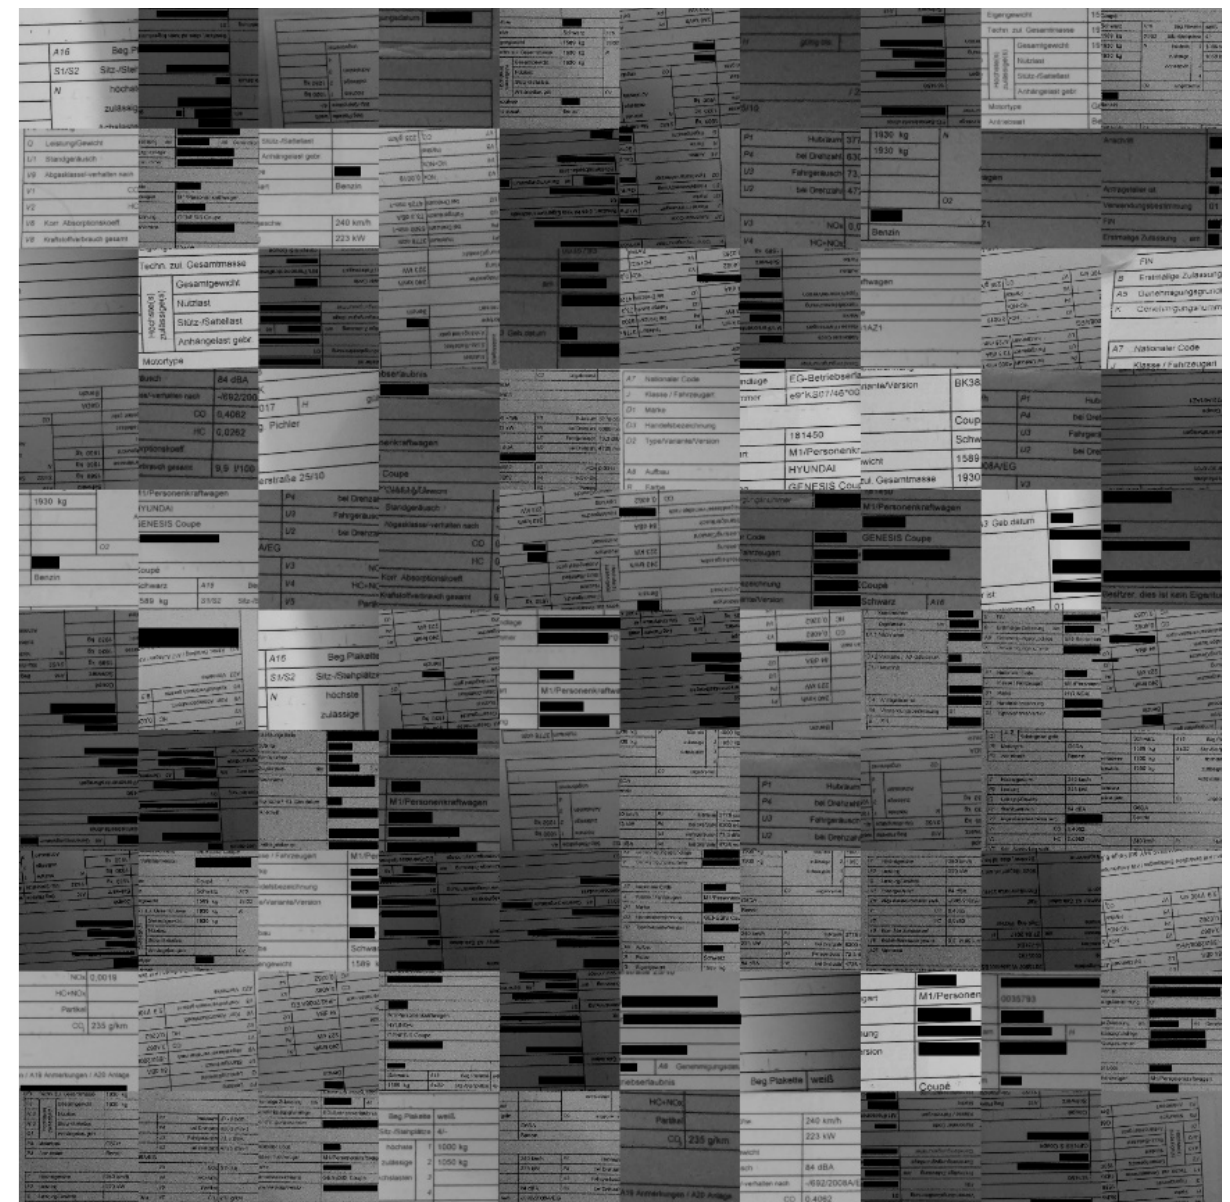
Figure 7. These are 100 “bad quality” sample data extracted from our own dataset (an extract from a much bigger dataset). Note: since the images contain some personal data, those parts are covered by black rectangles for privacy reasons. The sample images of the benchmarking dataset collected under realistic harsh con- ditions were sorted based on the text recognition performance of Tesseract (open-source OCR software) on them. Five different categories were defined: (1) very good images on which the OCR can detect the words with an accuracy in the range of 90–100%(see samples in Figure 10); (2) good images on which the OCR can detect the words with an accuracy in the range of 80–90% (see samples in Figure 9); (3) medium images on which the OCR can detect the words with an accuracy in the range of 70–80% (see samples in Figure 8); (4) bad images on which the OCR can detect the words with accuracy in the range of 60–70% (see samples in Figure 7); (5) and very bad images on which the OCR can detect the word with accuracy lower than 60% (see samples in Figure